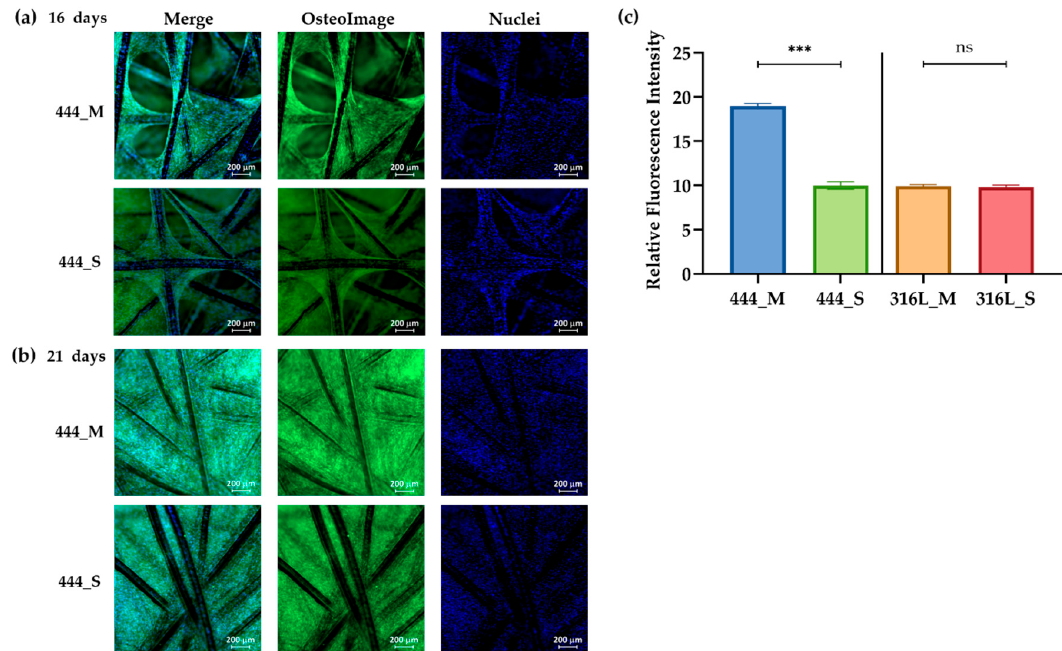
Figure 4. Fluorescence imaging of mineralization obtained using the OsteoImage Mineralization Assay, for 444 actuated and non-actuated networks on days ( a ) 16 and ( b ) 21 of culture. OsteoImage is a fluorescent assay that stains bone-like minerals (including hydroxyapatite) in green and DAPI (blue) was used to counter-stain the fixed cells. ( c ) Quantification of relative staining intensities on day 21 day for all the tested groups using ImageJ. Bars represent the mean ± standard error for each tested group ( n = 3 independent experiments). Statistical analysis was conducted by unpaired t test, *** p < 0.001, ns: no statistical significance.